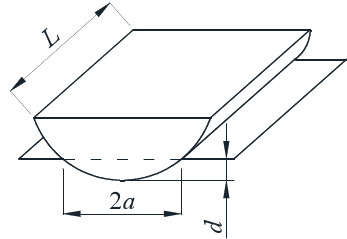
Figure 2. Contact form between rigid cylinder and elastic half space body.